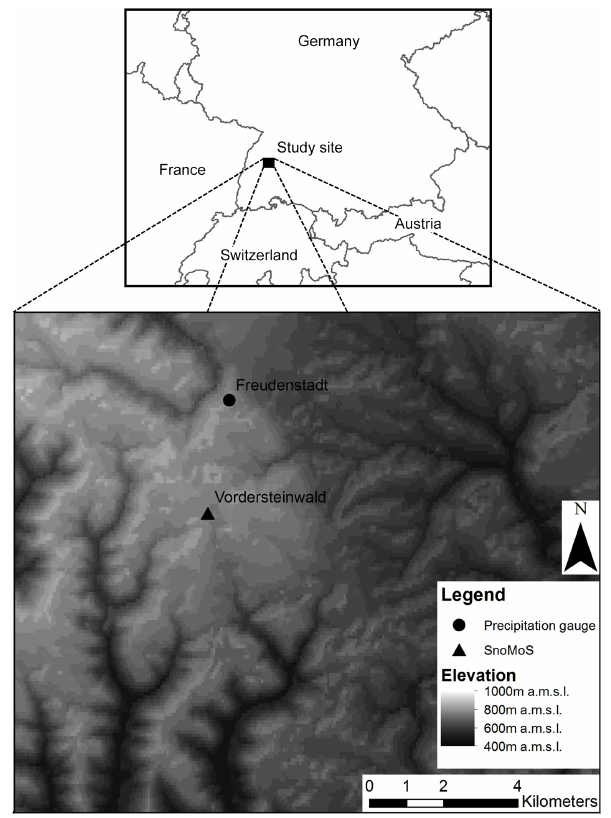
Figure 1. The Vordersteinwald site in the Black Forest mountain range (southwestern Germany, 800ma.s.l.).